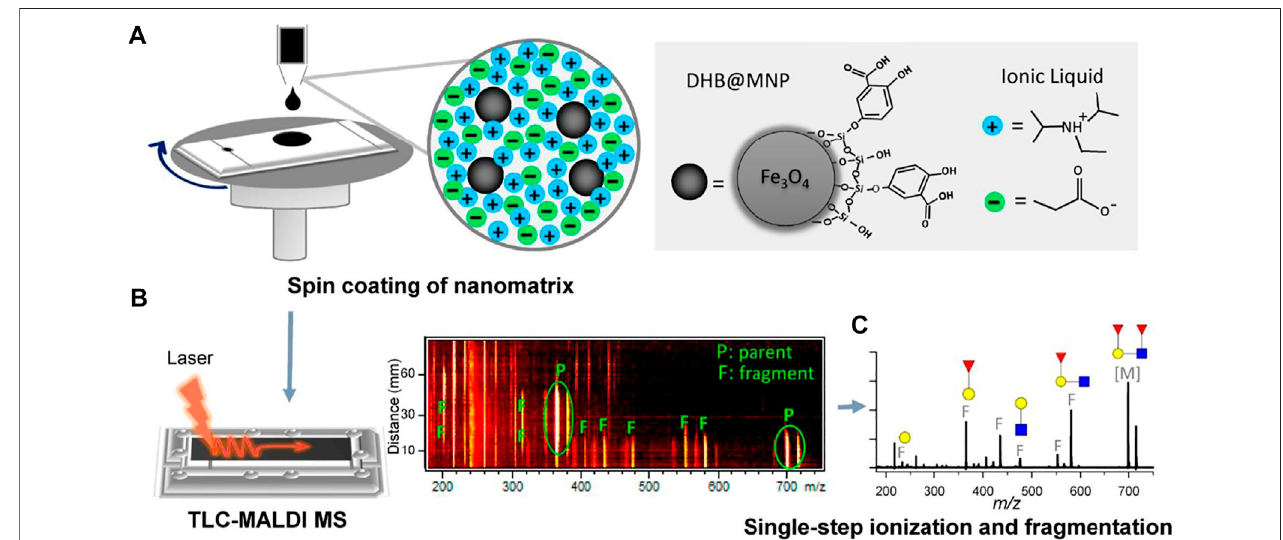
FIGURE 2 | Analytical work fl ow of DHB@MNP-assisted TLC-MALDI-MS using a saccharide mixture as a model (Mernie et al., 2019). (A) Saccharide mixture was separated on a C18-modi fi ed TLC plate, and the DHB@MNP nanomatrix was deposited on the TLC surface by spin-coating with the ionic liquid. (B) Automated scanning of the entire TLC separation lane was performed to obtain TOF-MS spectra at different migration distances. (C) Finally, on-spot structural elucidation of the saccharides was performed based on the parent and fragment ions generated from DHB@MNP-assisted fragmentation in single TOF-MS. Figure reprinted with permission from Mernie et al. (2019). Copyright (2019) the American Chemical Society (ACS).